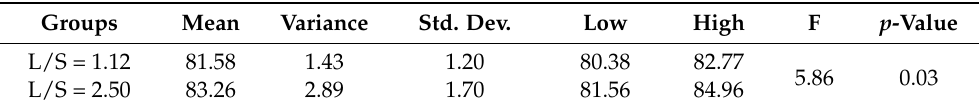
Table 8. ANOVA results of ethanol yields at different pretreatment temperatures and ammonia loadings (at L/S = 2.50). Groups Mean Variance Std. Dev. Low High F p -Value (L/S = 2.50) 90 ◦ C